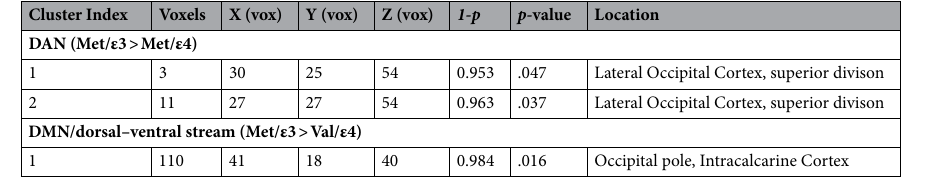
Table 3. Apolipoprotein E (APOE) * Brain-derived neurotrophic factor ( BDNF) Interaction. APOE = Apolipoprotein E; BDNF = brain-derived neurotrophic factor; DMN = Default mode network; DAN = Dorsal Attention Network; GM = grey matter; Met/ε3 = participants not carrying the APOE ε4, but at least one copy of the BDNF Met alleles; Met/ε4 = participants carrying at least one copy of the APOE ε4/ BDNF Met alleles; Val/ε4 = participants being a Val homozygote and carrying at least one of the APOE ε4 alleles; Val / ε3 = participants not carrying the APOE ε4 allele and being a Val homozygote.